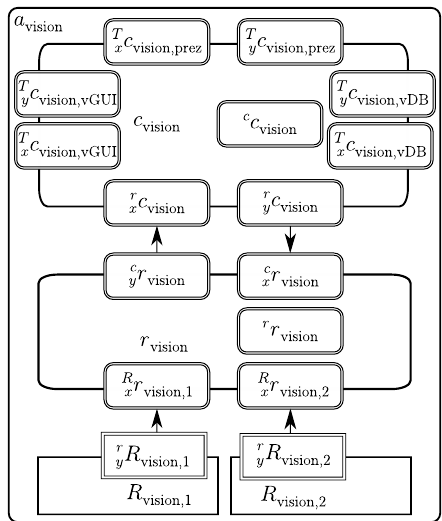
Figure 10. Structure of the agent a vision .